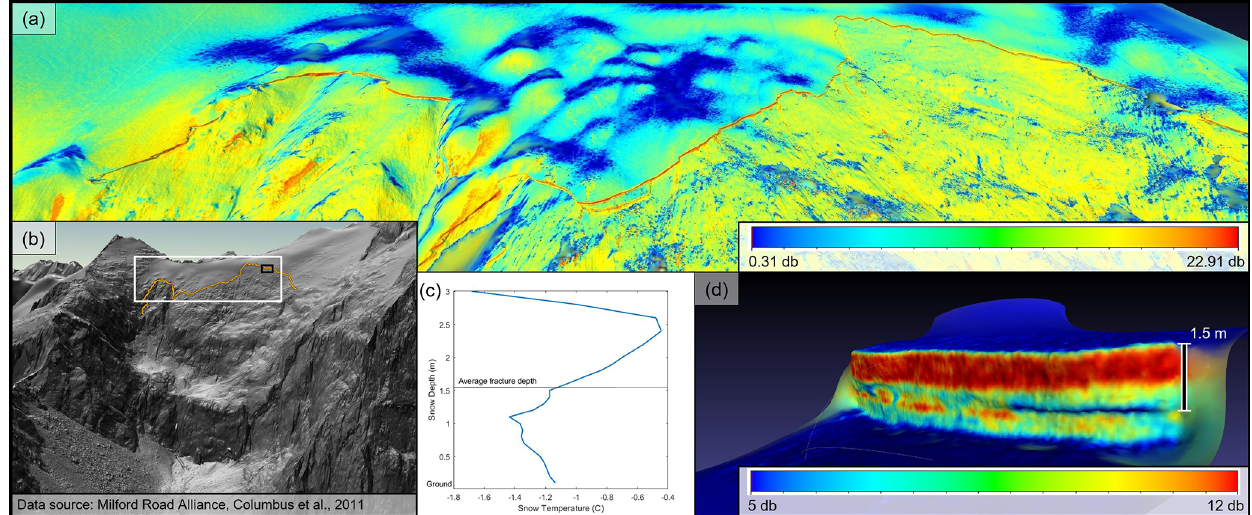
Figure 11. Composite showing amplitude of lidar return from scan of the release area the morning after the avalanche event in panel (a) . Panel (b) is a hillshade of the avalanche path from the 0.5m full-resolution TLS-derived DSM, which also depicts the location of panel (a) in white and panel (d) in black. Panel (c) shows the temperature profile of the snowpack at the closest weather station at 1700ma.s.l. and depicts the average fracture depth used for the RAMMS simulations, based on the TLS data. Panel (d) shows a higher-resolution scan of the face of the crown wall from the morning after the avalanche, also visualizing the amplitude. Note the different scale bar ranges. The snow depth value in panel (d) is indicative of the average fracture depth for the